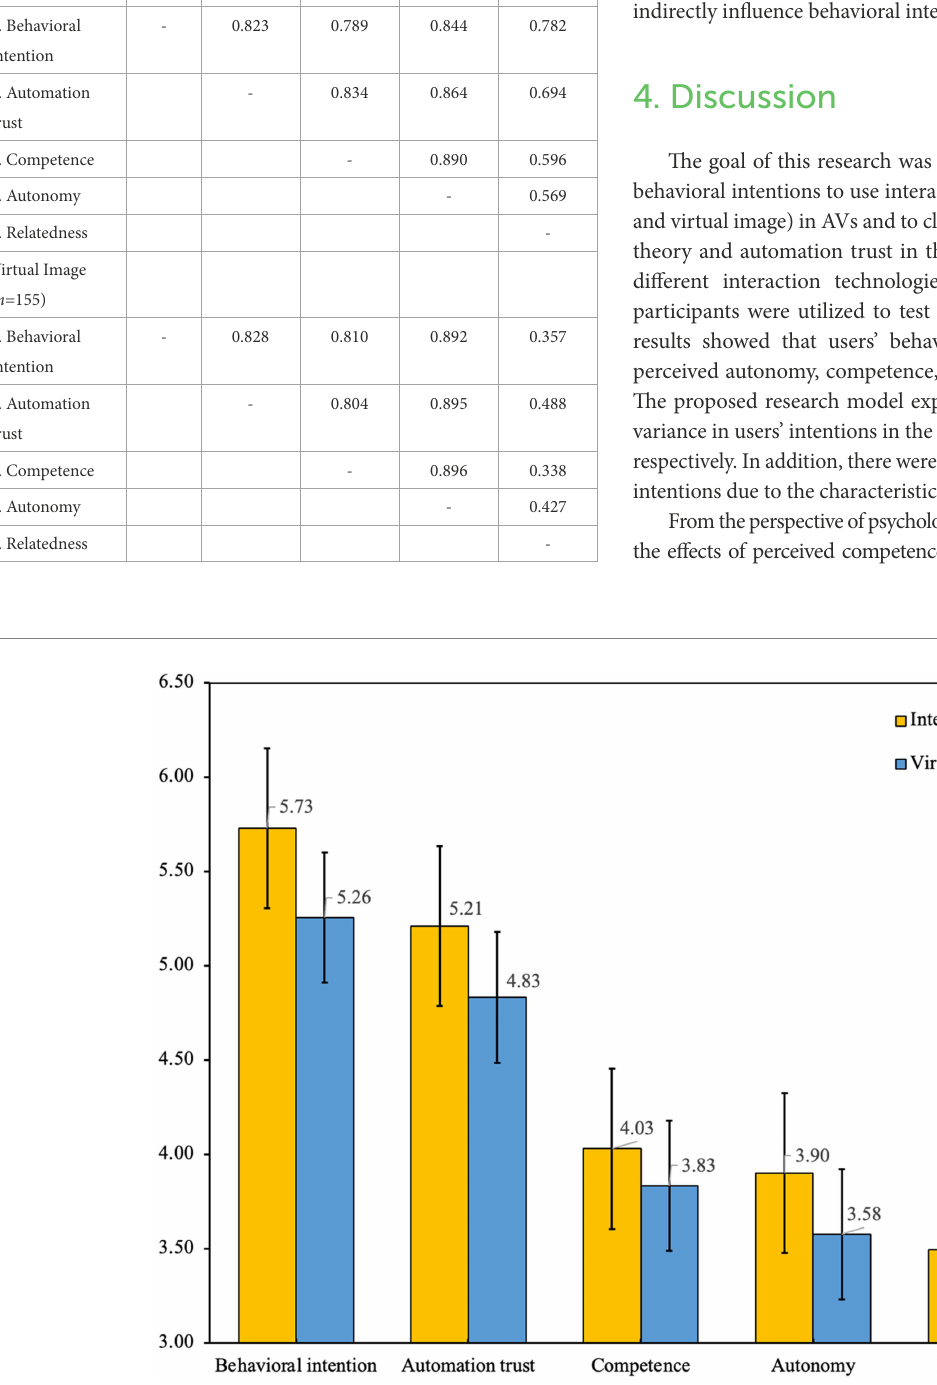
FIGURE 5 Mean score chart of the interaction mode and virtual image. Note: The scales for behavioral intention and automation trust were measured using a 7-point Likert scale, and the scales of competence, autonomy and relatedness were measured using a 5-point Likert